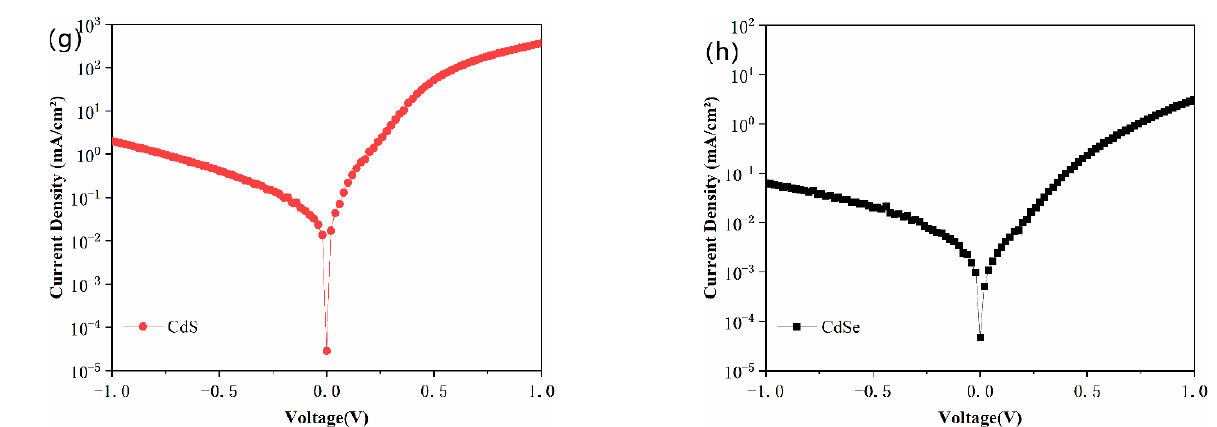
Figure 5. ( a ) The NC solar cell configuration; ( b ) Band alignment of the NC solar cell; J-V curves of ( c ) ITO/ZnO/CdSe/CdTe/Au and ( d ) ITO/ZnO/CdS/CdTe/Au with different annealing temperatures under light. The corresponding EQE spectra of ( e ) ITO/ZnO/CdS/CdTe/Au ( f ) ITO/ZnO/CdSe/CdTe/Au; J - V curves of ( g ) ITO/ZnO/CdS/CdTe/Au and ( h ) ITO/ZnO/CdSe/CdTe/Au under dark. Table 1. Summarized performance of CdTe/CdSe NC solar cells with different annealing temperatures (Figure 5a). Annealing